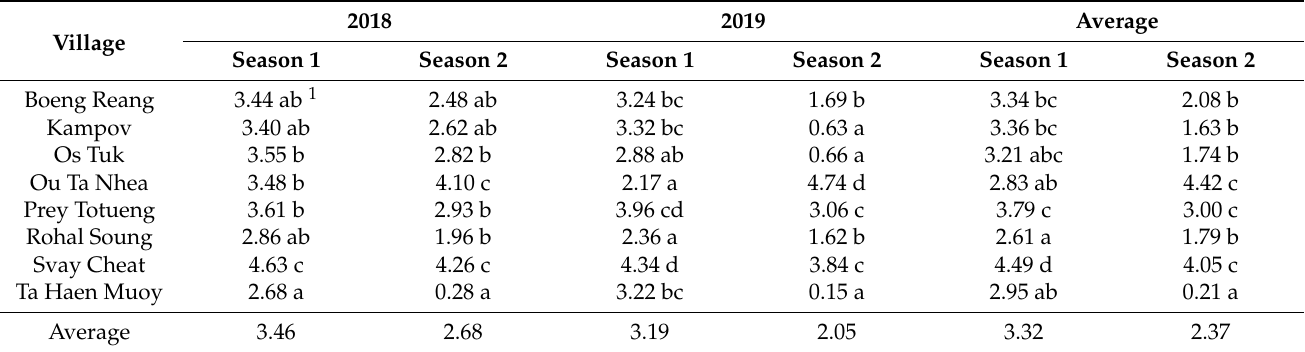
Table 2. Rice yields in 2018, 2019 and the average for the two years (t ha − 1 ).